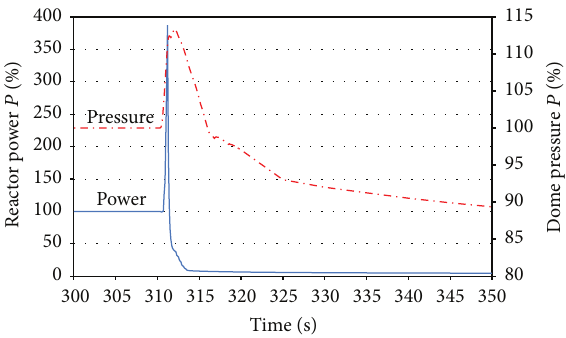
Figure 3: Reactor power and dome pressure evolution during the first seconds of the